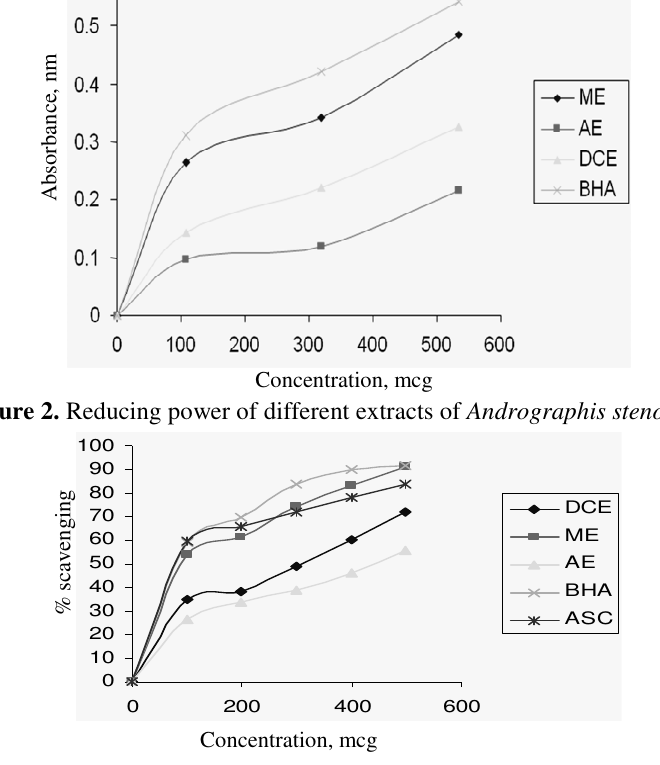
Figure 3. DPPH radical scavenging activity of Andrographis stenophylla leaf (ASC – Ascorbic